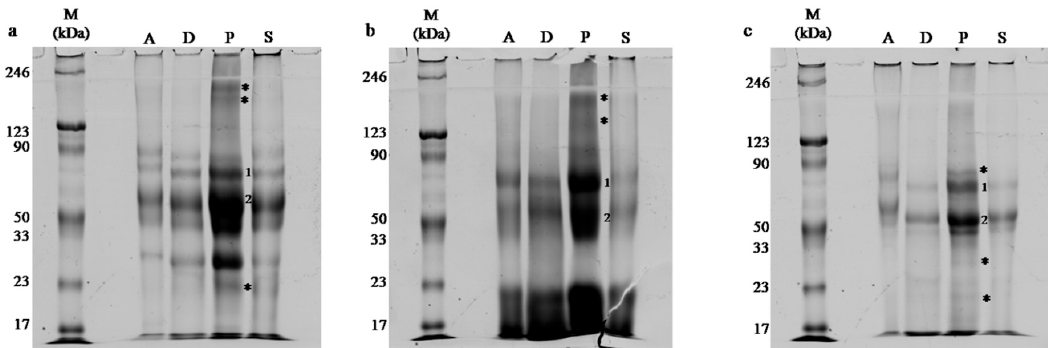
Figure 3. Gels obtained after SDS-PAGE electrophoresis of the: ( a ) black locust honey, ( b ) buckwheat honey, ( c ) rapeseed honey; 20 µ g of protein were loaded on each lane. A—precipitation with acetone,